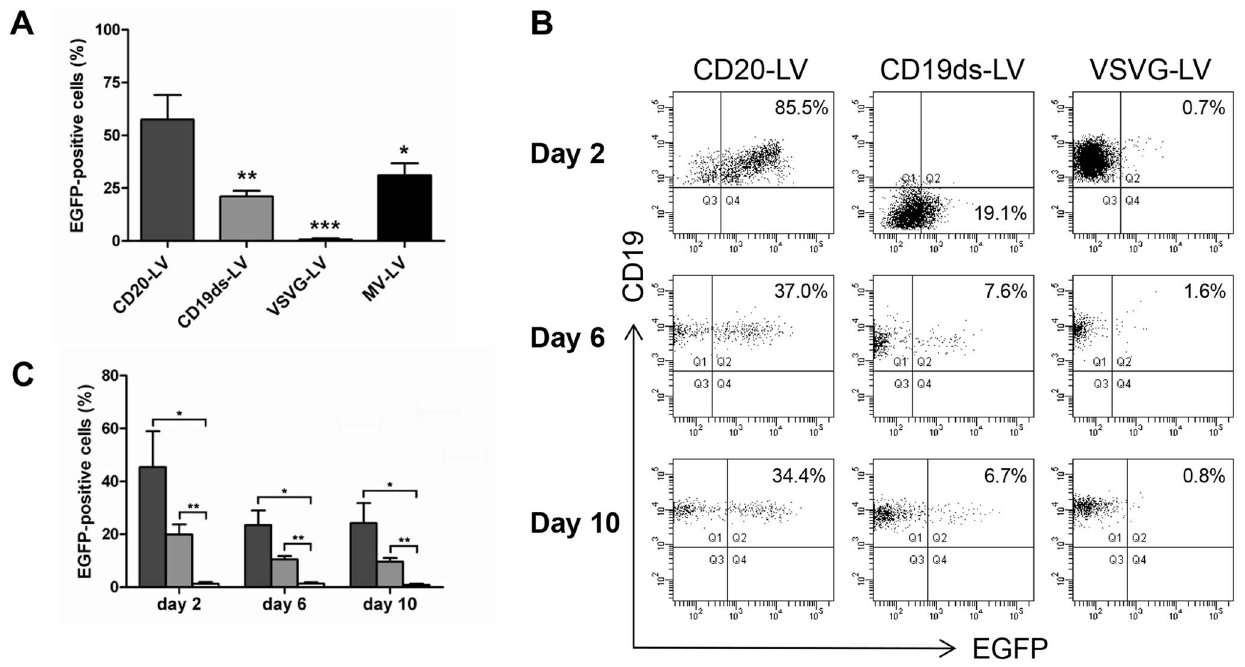
Figure 3. Stable transduction of unstimulated primary human B lymphocytes by CD20-LV and CD19ds-LV. ( A ) Freshly isolated primary human B lymphocytes from six different donors were transduced with CD20-LV, CD19ds-LV or MV-LV at an MOI of 2, or VSVG-LV at an MOI of 100. Forty-eight hours later, B lymphocytes were identified by their CD20 expression and the percentage of EGFP + cells in the CD20-gated cells was determined by FACS analysis. Results are expressed as mean 6 SEM. *, ** and *** indicate P , 0.05, P , 0.01 and P , 0.001 versus transduction with CD20-LV, respectively. Data were analyzed by one-way ANOVA. ( B–C ) To verify stable integration of the egfp gene into the B lymphocyte genome, freshly isolated primary human B lymphocytes (purity was , 99.8%) from three different donors were transduced with the indicated vectors. Transduced cells were cultivated in presence of 10 ng/ml rhIL-15 and 10 ng/ml rhIL-2 for 10 days on MS-5 feeder cells. The percentage of CD19 + / EGFP + cells in the CD20-gated cells was determined by FACS analysis at the indicated time points. ( B ) FACS blots of one representative experiment are shown (at least 2000 B lymphocytes were gated for analysis). ( C ) Diagram showing a summary of all three independent experiments. Dark gray column: CD20-LV; light gray column: CD19ds-LV; white column: VSVG-LV. Results are expressed as mean 6 SEM. * and ** indicate P , 0.05 and P , 0.01 for CD20-LV and CD19ds-LV versus VSVG-LV, respectively. Data were analyzed by Student’s t-test without adjustment of multiple comparisons.